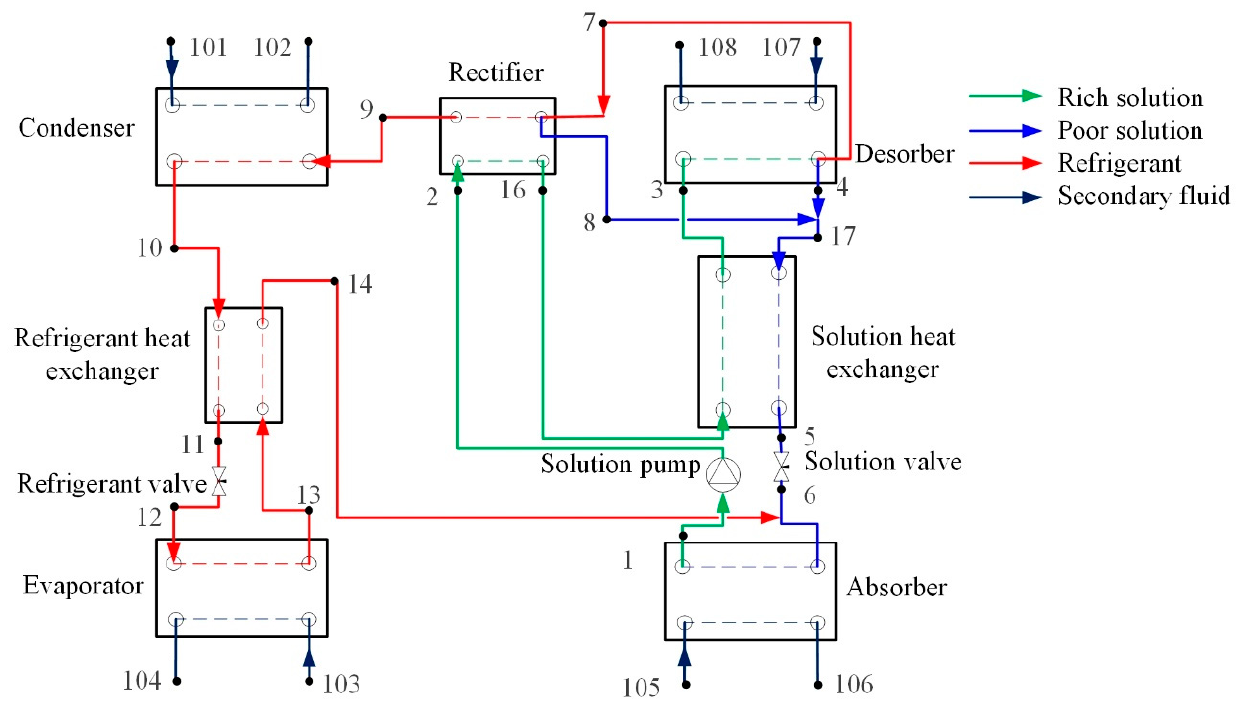
Figure 1. Flow diagram of the basic single-stage ammonia/water absorption cycle with internally cooled rectifier and refrigerant heat exchanger.